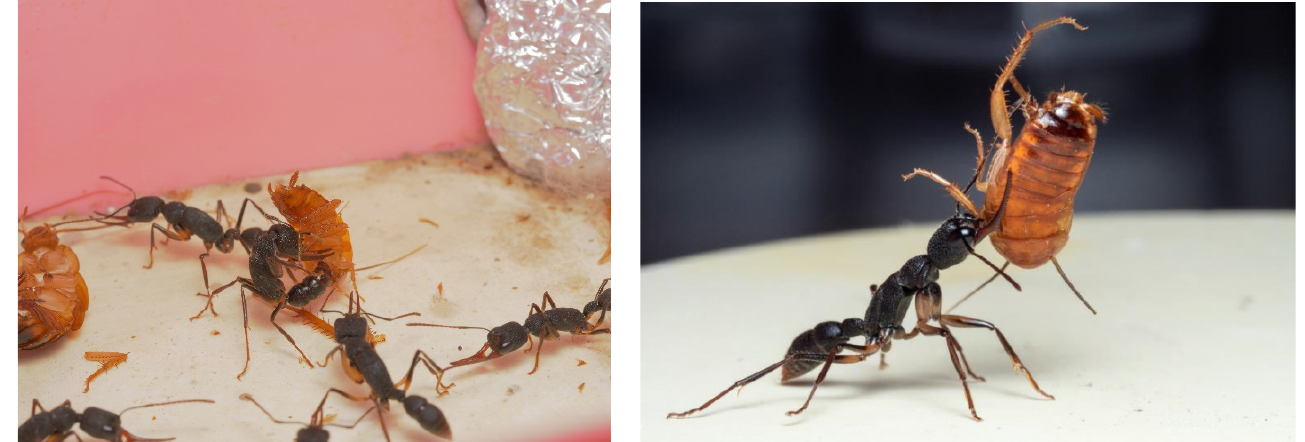
Figure 1. Sting ( left ) and transport ( right ) of Blatta lateralis by H. venator . Photo by Yanming Liu.